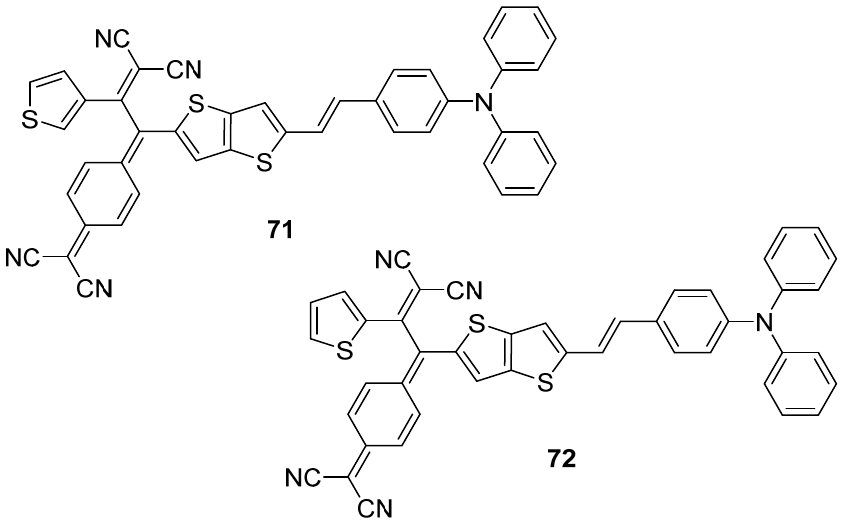
Figure 8. Thieno[3,2- b ]thiophene as a π -linker in the push–pull chromophores.